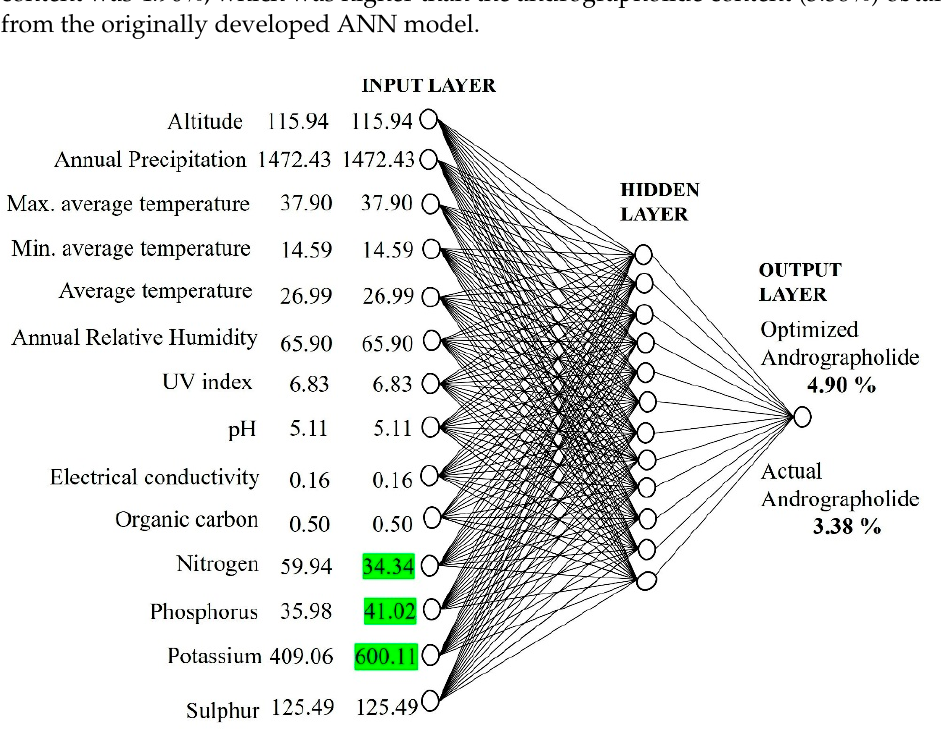
Figure 4. Optimization of andrographolide content by changing input parameters of the ANN model.